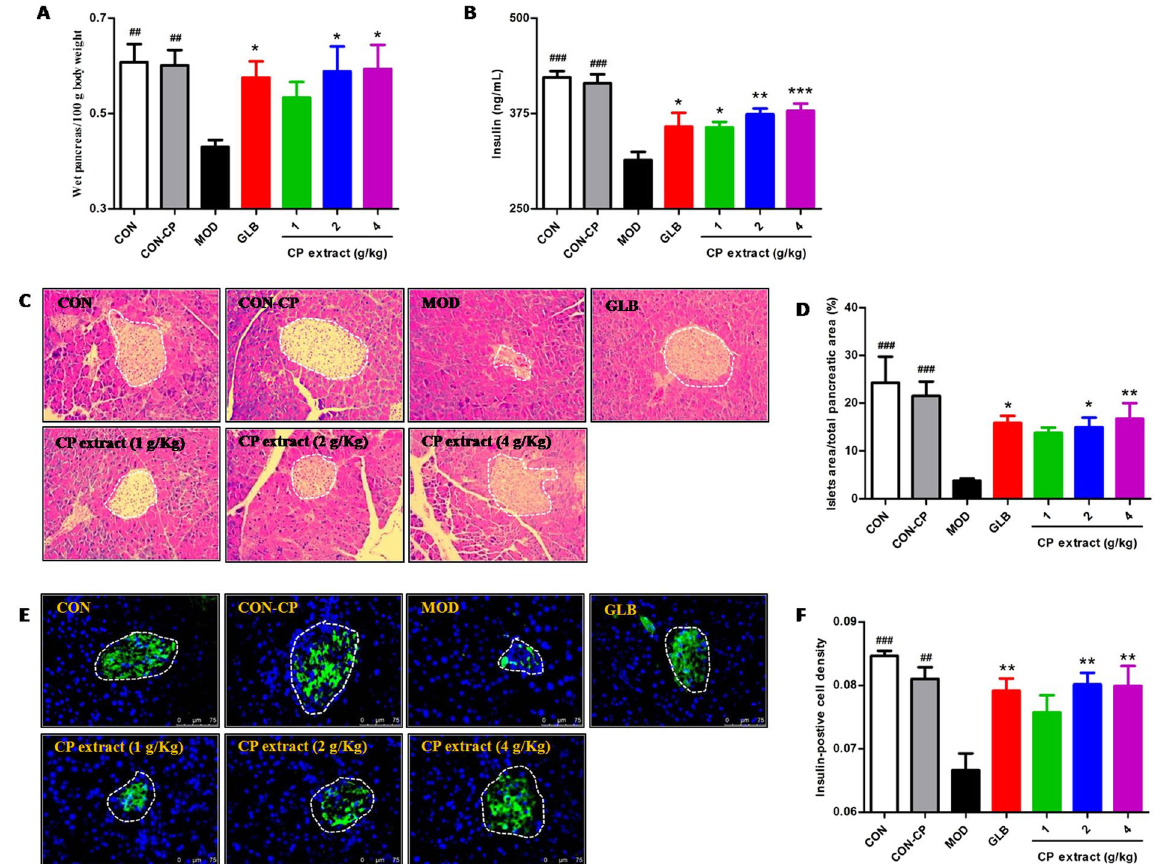
Figure 2. CP extract prevents pancreatic β cell mass decrease in diabetic mice. The type 2 diabetic mice were induced by feeding with high-fat diet for 4 weeks and then injecting intraperitoneally with 25 mg/kg STZ for 3 days consecutively. The diabetic mice with consecutive 7-day hyperglycemia (11 mmol/L or greater) were selected for the experiment and then CP extract or glibenclamide were administered to mice for consecutive 5 weeks. At the end of experiment, mice were sacrificed. The samples of blood and pancreas tissues were collected. ( A ) Relative weight of wet pancreas; ( C ) Histopathological examination of pancrease tissues (H & E staining) (magnification, 100 × ) and ( E ) Immunofluorescence (IF) analysis of insulin-positive cell using insulin marker (magnification, 600 × ). ( B ) Blood insulin levels; ( D ) Relative islets area in total pancreatic area; ( F ) Insulin- positive cell intensity. Blood insulin levels were assayed using commercially available kits (Wuhan Fine Biotech Co. Ltd, China). All data are presented as means ± SEM (n = 8). # p < 0.05, ## p < 0.01 and ### p < 0.001, diabetic model group compared with non-diabetic groups; * p < 0.05, ** p < 0.01 and *** p < 0.001, compared with diabetic model group. CON: non-diabetic control group; CON-CP: CP extract-treated non-diabetic control group; MOD: diabetic model group; GLB: glibenclamide-treated diabetic